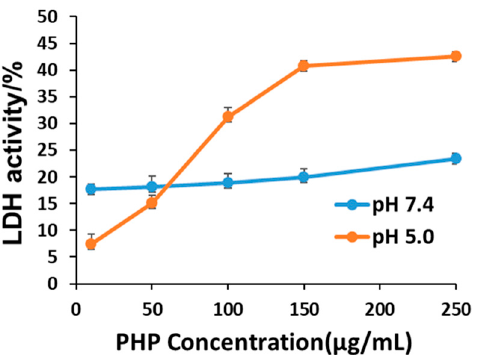
Figure 7. LDH liberated from MCF-7/ADR cells upon PHP at 37 °C for 1.5 h. Results were expressed as mean ± SEM ( n = 6).